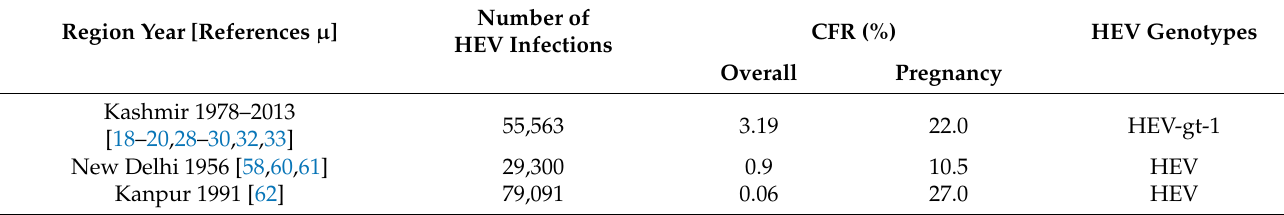
Table 1. Epidemics of hepatitis E with number of recorded cases, case fatality rate (overall and in pregnant women) and relationship with hepatitis E virus